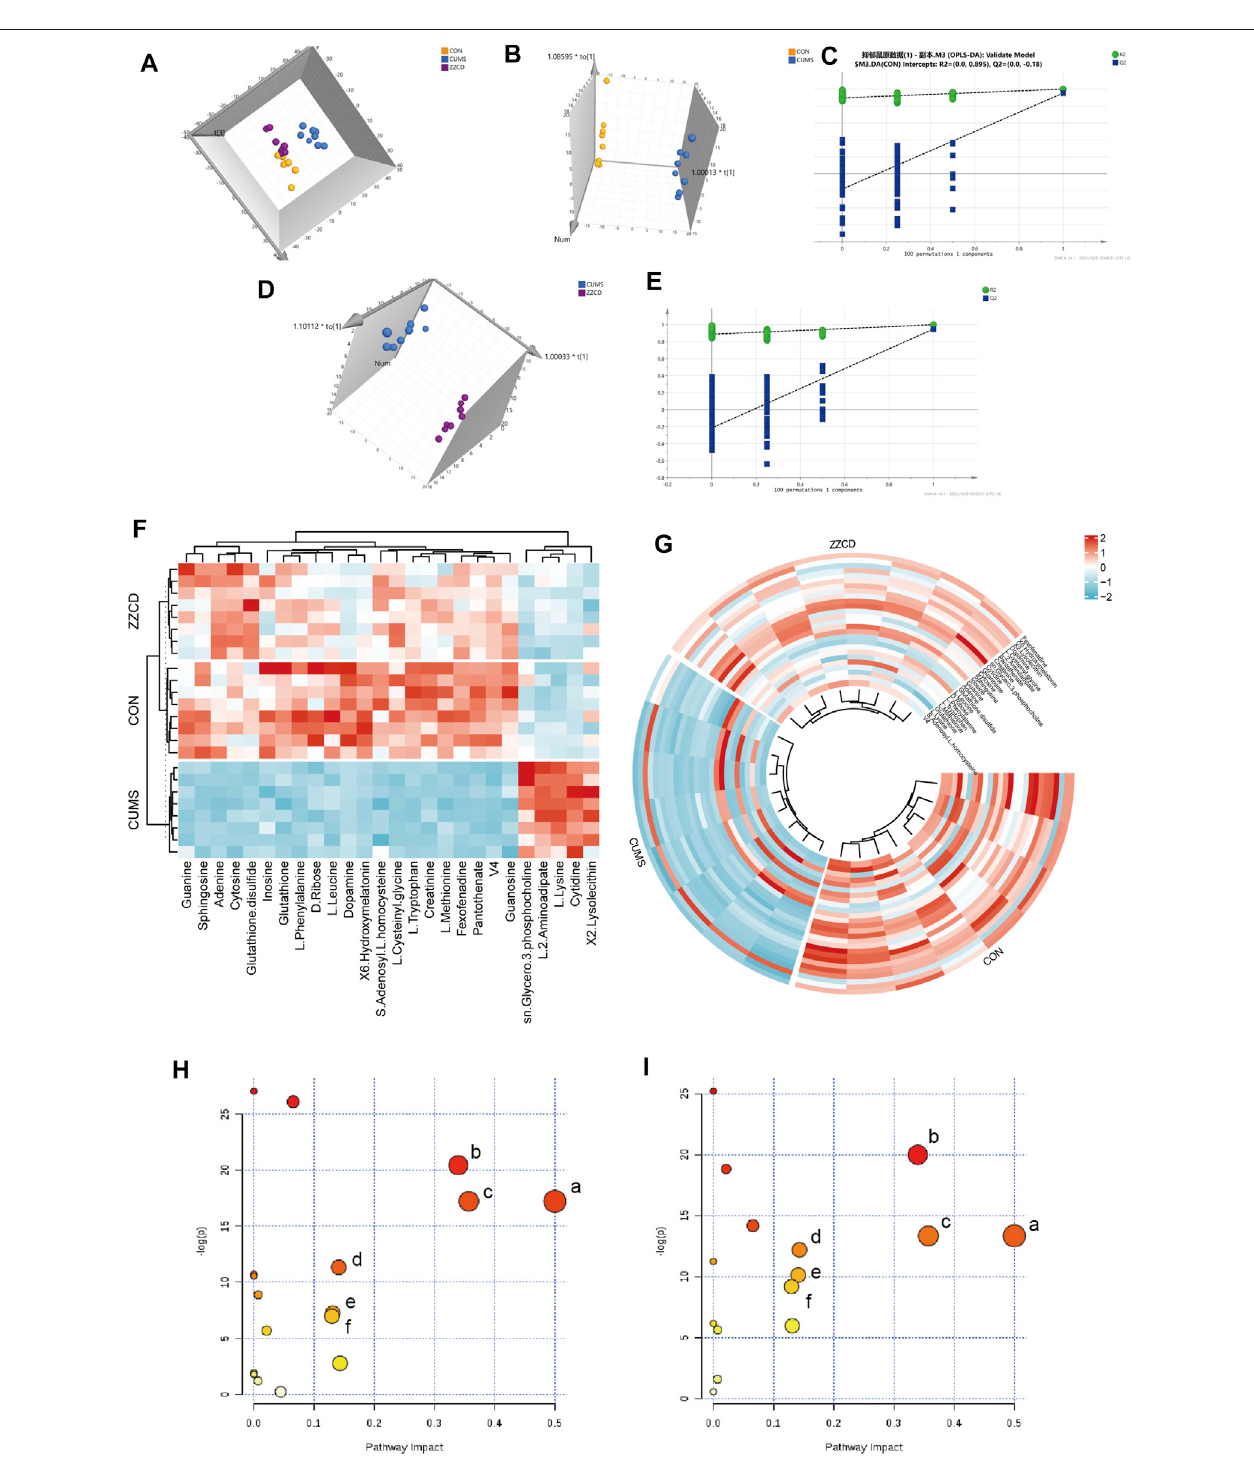
FIGURE 2 | Multi-variate data analysis results. PCA scores plot of CON (yellow), CUMS (blue) and ZZCD (purple) group (A) , OPLS-DA scores plot of CON (yellow) and CUMS (blue) group (B) , Validation plot of CON and CUMS group by permutation tests (C) , OPLS-DA scores plot of CUMS (blue) and ZZCD (purple) group (D) , Validation plot of CUMS and ZZCD group by permutation tests (E) . Hierarchical clustering heat-map of the 26 differential metabolites (F,G) . Metabolic pathway analysis of CON vs. CUMS group, Phenylalanine, tyrosine and tryptophan biosynthesis (a), Glutathione metabolism (b), Phenylalanine metabolism (c), Lysine degradation (d), Cysteine and methionine metabolism (e), Tyrosine metabolism (f) (H) Metabolic pathway analysis of CUMS vs. ZZCD group, Phenylalanine, tyrosine and tryptophan biosynthesis (a), Glutathione metabolism (b), Phenylalanine metabolism (c), Tryptophan metabolism (d), Lysine degradation (e), Tyrosine metabolism (f) (I) .